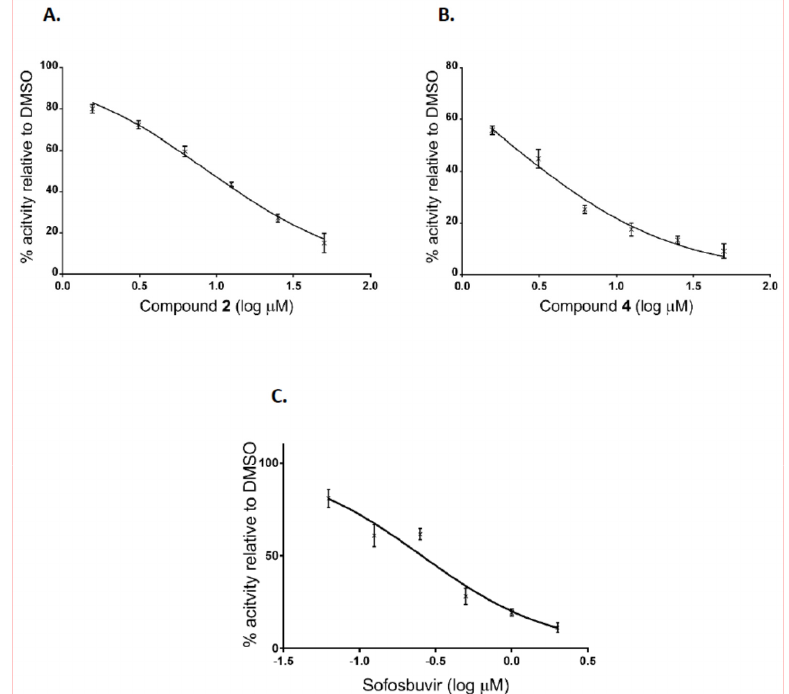
Figure 4. Inhibition curves of uridine derivatives of 2 ‐ deoxy sugars (compounds 2 and 4 ) and sofosbuvir. HCV infected Huh7 ‐ J20 cells were incubated for 72 h in the presence of varying concentrations of compound 2 ( A ), 4 ( B ), or sofosbuvir ( C ) and their effect on viral replication was evaluated by SEAP assay from the culture supernatant. Each concentration was tested in triplicate and the results are expressed as the mean and standard